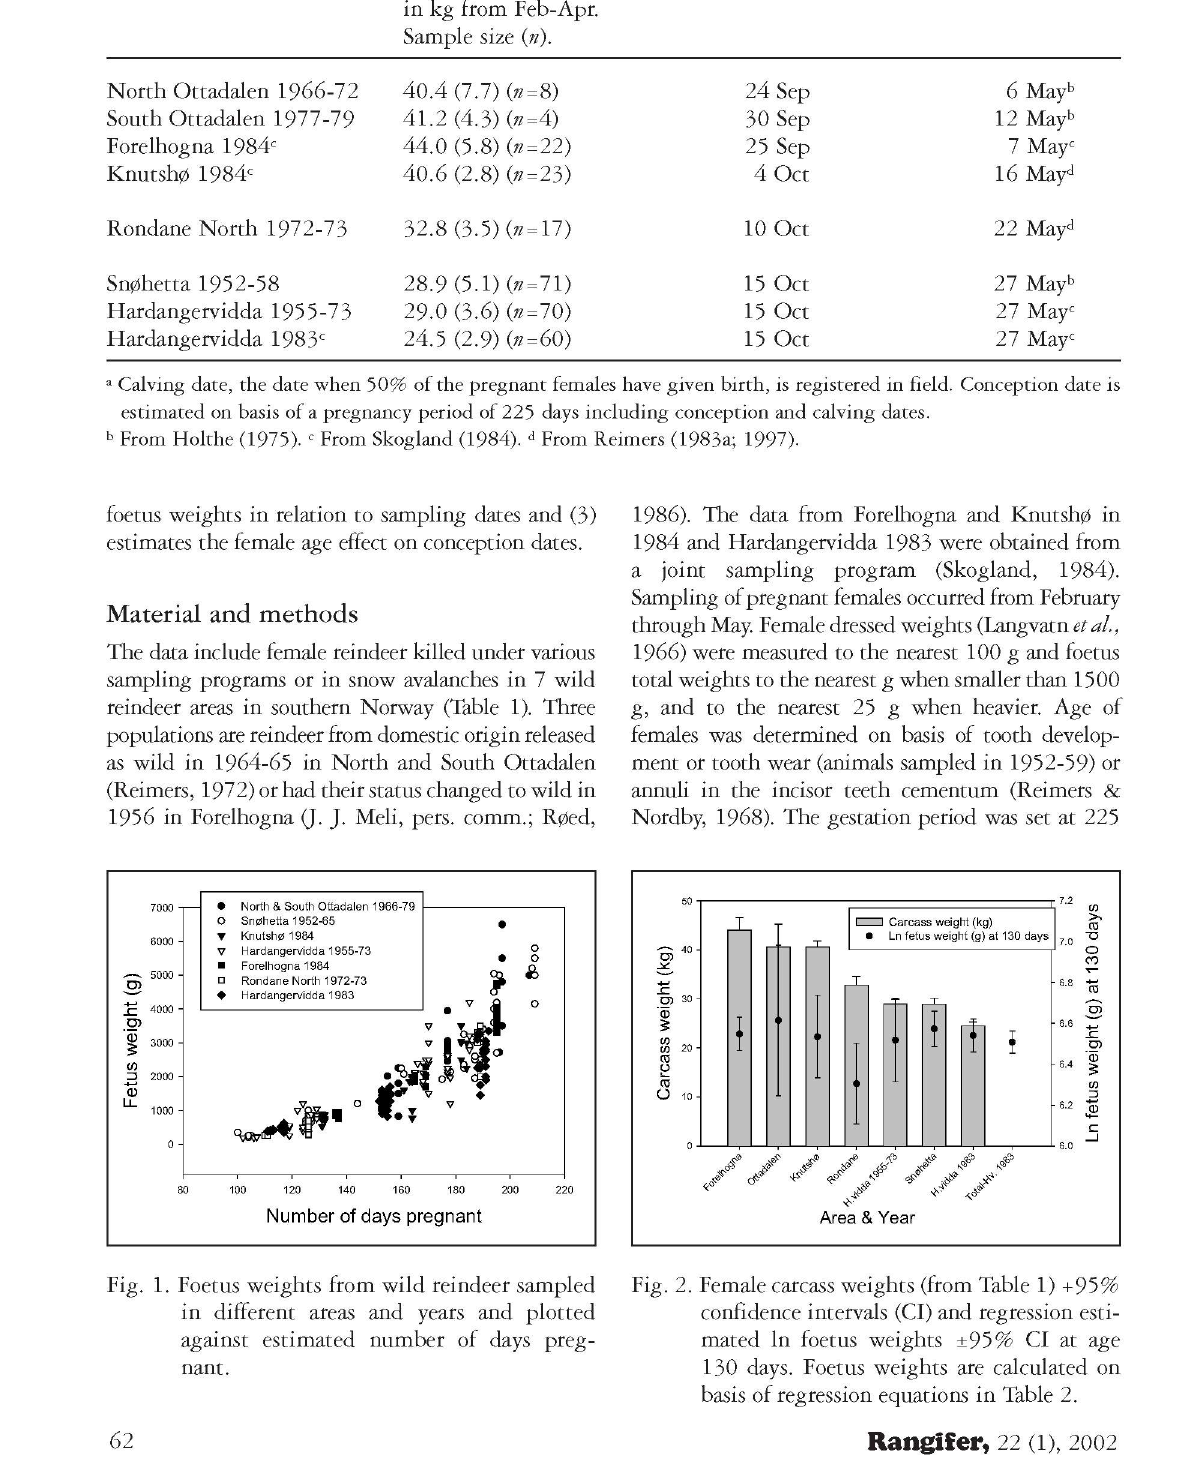
Fig. 1. Foetus weights from wild reindeer sampled in different areas and years and plotted against estimated number of days preg¬ nant.